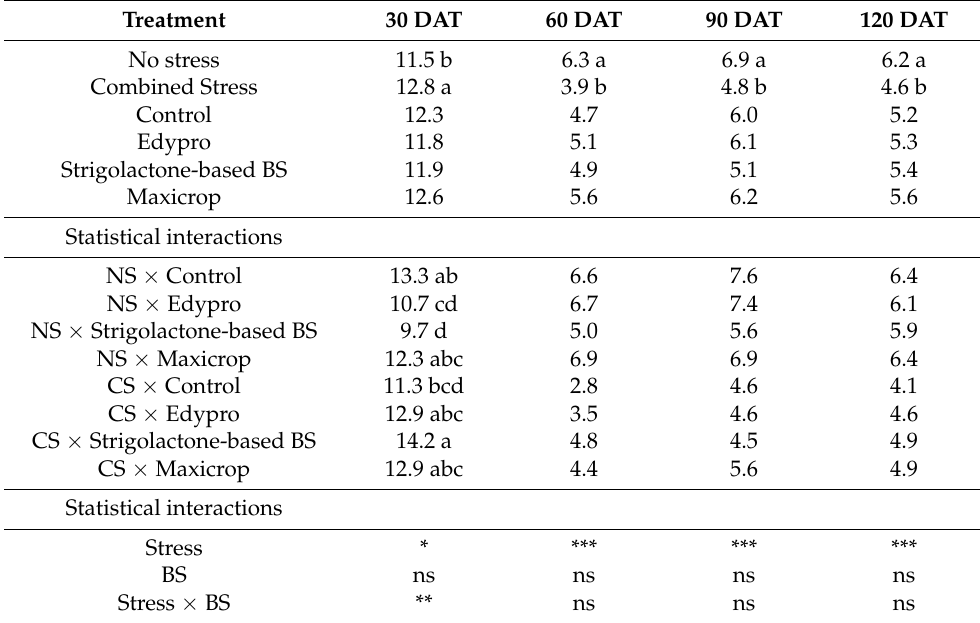
Table 1. Effects of combined restriction of water and nutrients (No stress, NS; Combined stress, CS), and biostimulant (BS) application (Control: No biostimulant applied, Edypro: application of COUP É REGENERACI Ó N and PROCUAJE RADICULAR, strigolactone-based biostimulant and Maxicrop) at K concentration (mmol L − 1 ) on tomato root zone 30, 60, 90, and 120 days after transplanting